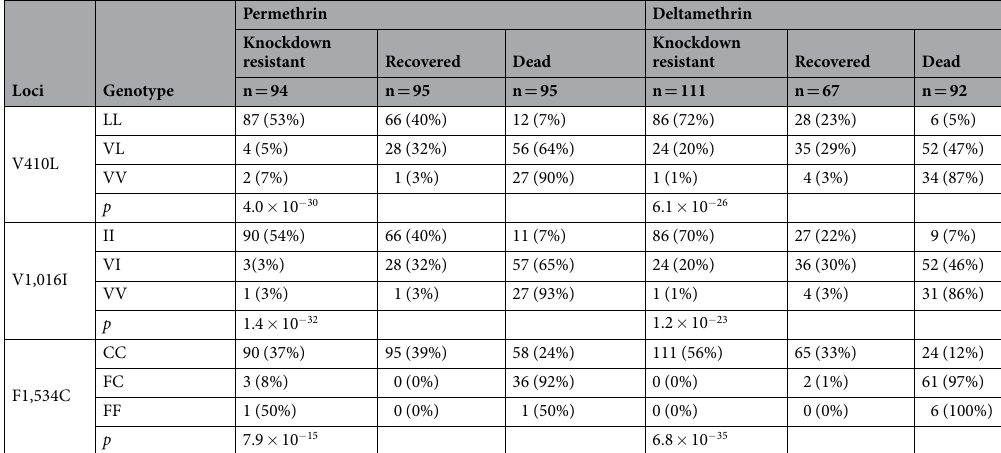
Table 3. Phenotype and genotype at loci 410, 1,016 and 1,534 analyzed separately in mosquitoes from Viva Caucel treated with permethrin or deltamethrin. The percentage of knockdown resistant, recovered and dead mosquitoes within the genotype group is shown in parenthesis. The p value corresponds to a 3 × 3 table contingency analysis performed for each locus.